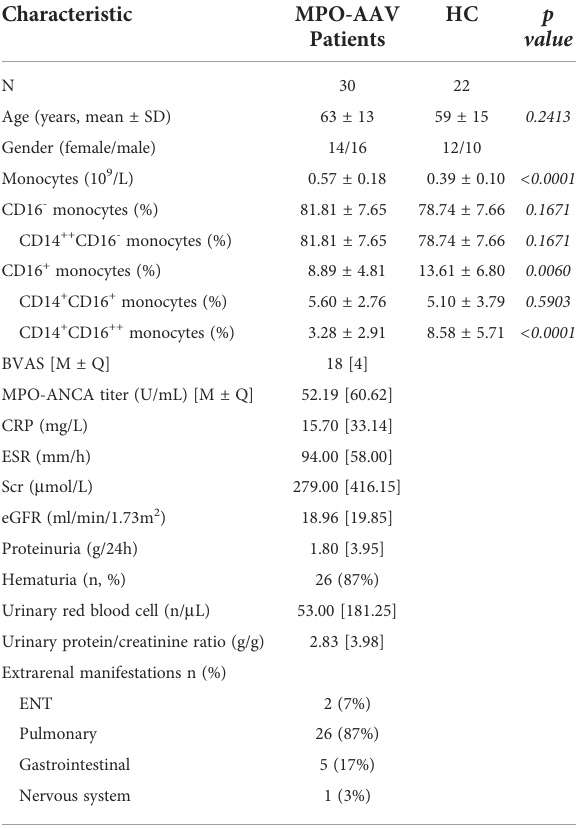
TABLE 1 Clinical and histopathological data of partial patients with blood drawing.